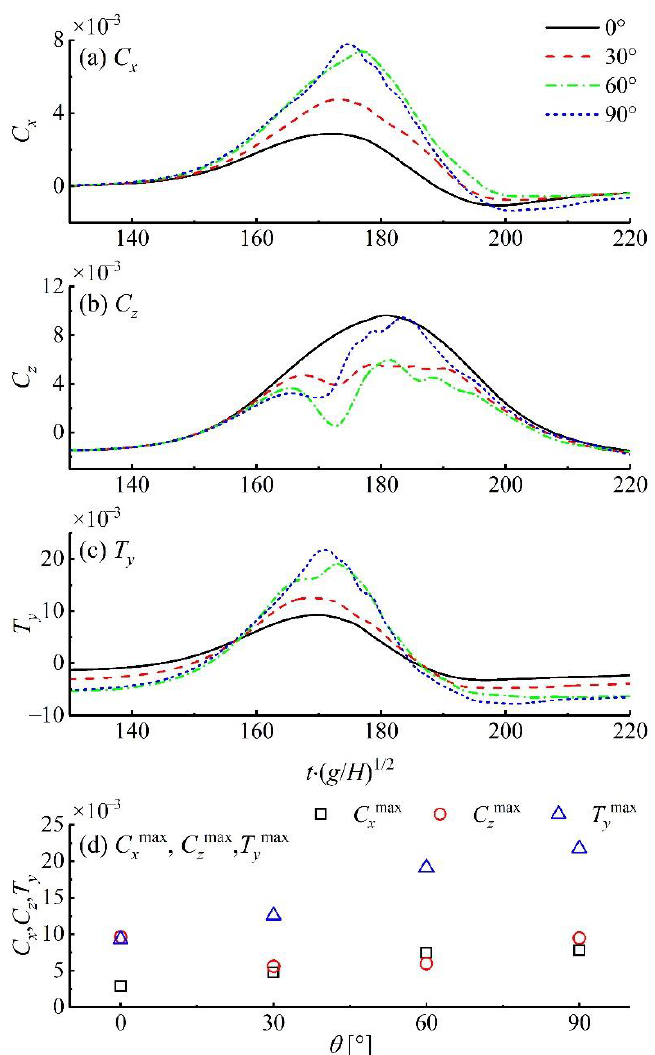
Figure 13. Forces and torques coefficients on the semi-submersible platform at different angles under the condition of Case A2.